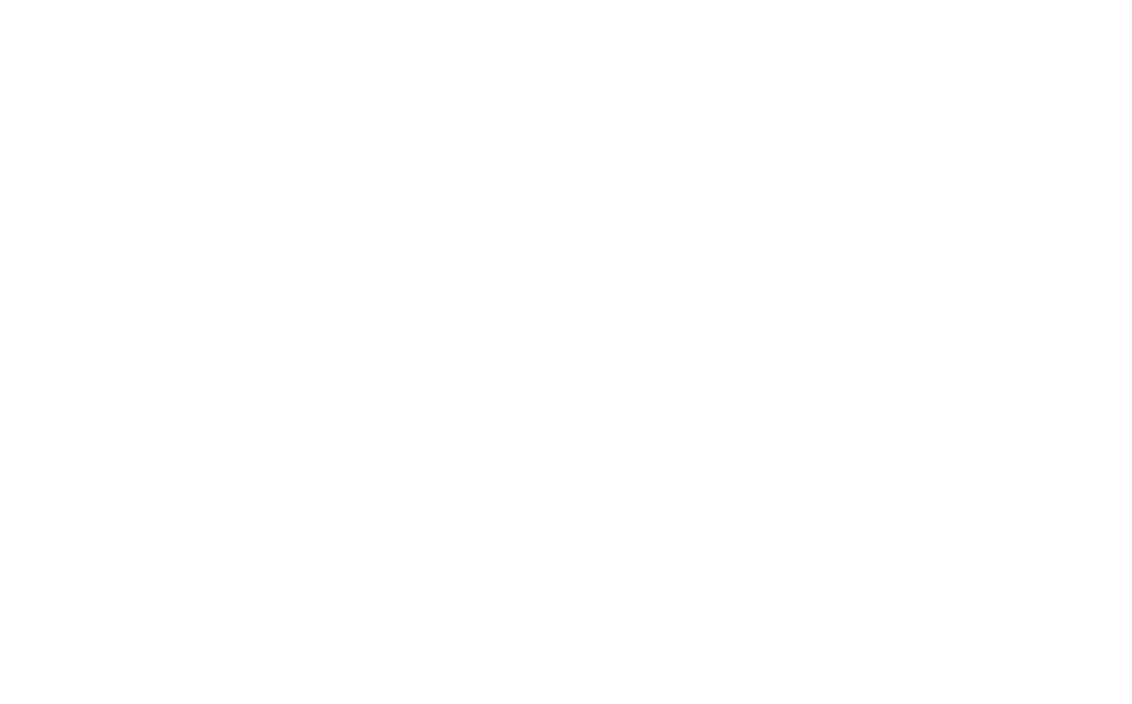
Table 4. Comparison of PSNR (dB) values obtained by different methods under Gaussian mixture model (GMM) noise.